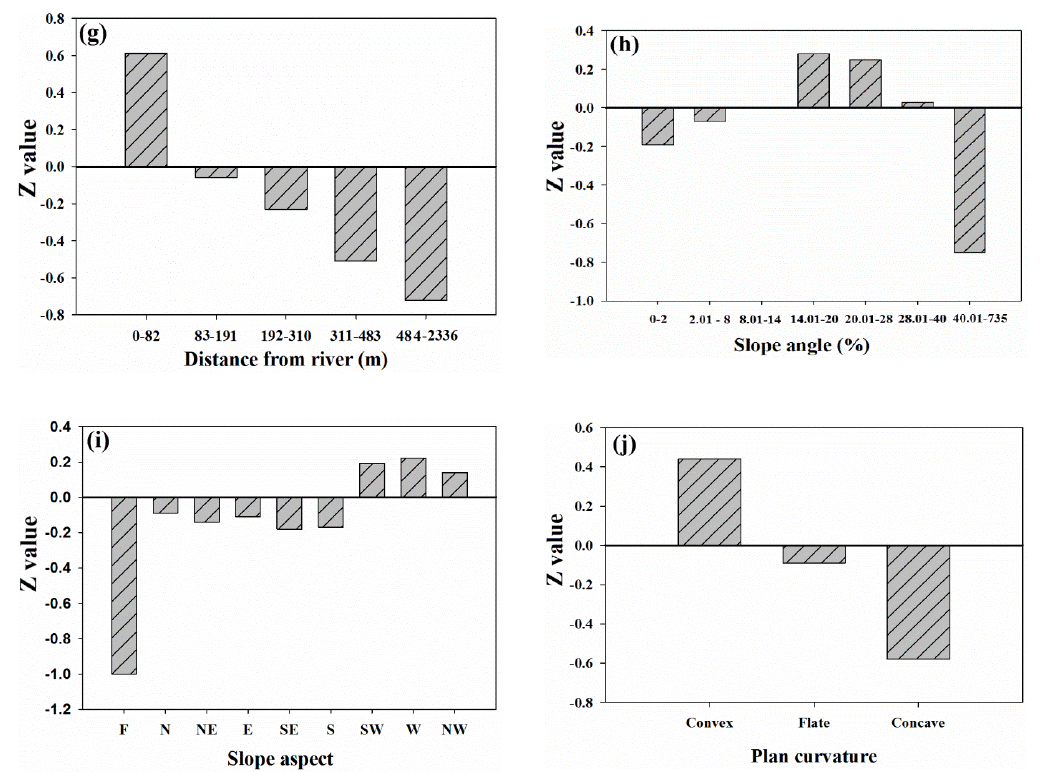
Figure 4. Results of the certainty factors ( CF) modelling per factor class.